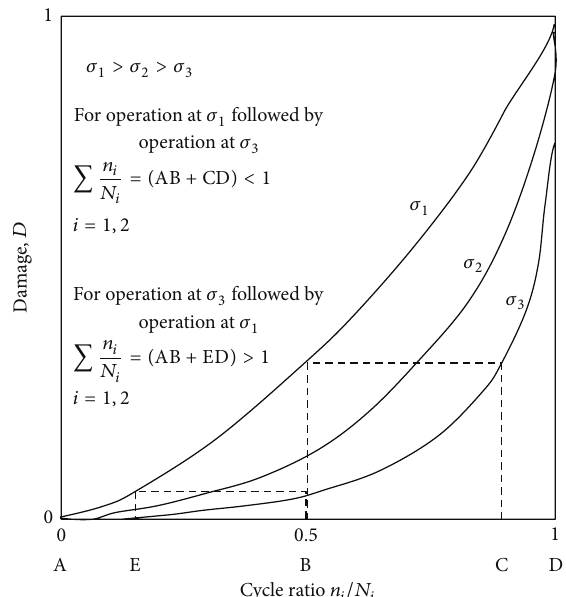
Figure 4: A schematic representation for the Marco-Starkey theory